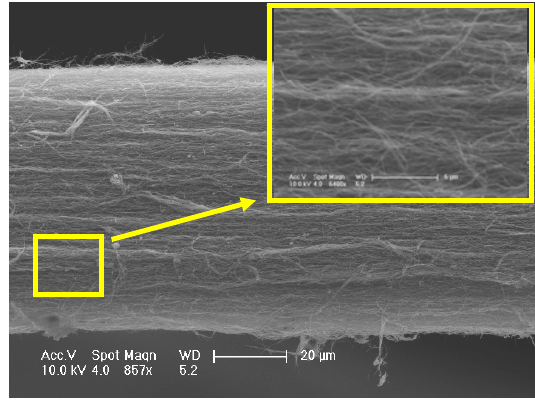
Figure 6. SEM images of MSCNTS (sample